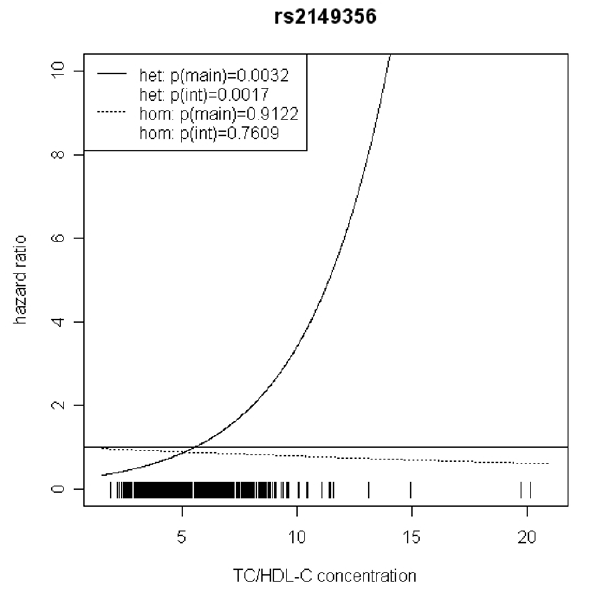
Figure 7 Hazard ratios of incident type 2 diabetes related to the respec- tive TC/HDL-C concentration in men for rs7873784 . Continuous lines represent subjects who are heterozygote or homozygote for the minor allele. Small bars at the x-axis indicate TC/HDL-C concentrations of patients with at least one copy of the minor allele.